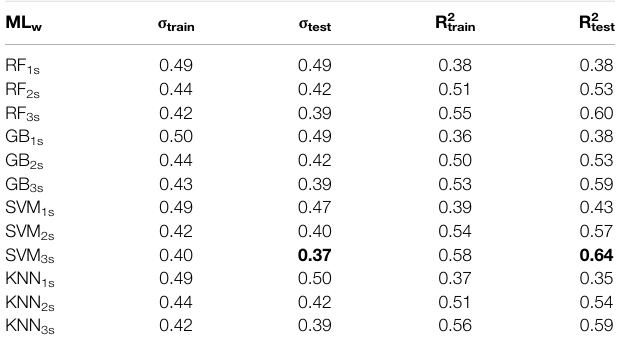
TABLE 4 | ML regression results, ANX dataset. TABLE 5 | ML regression results, SRC